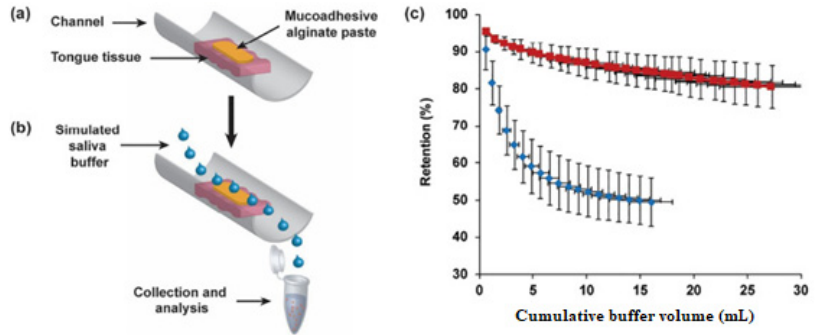
Figure 5. Assessment of mucoadhesion. ( a , b ) – preparation and buffer flow on sample, ( c ) Mucoadhesion evaluation of 3% ( w / v ) alginate-fluorescein ( ) paste; ( ) cross-linked paste on porcine tongue. Reprinted from ref. [88] with permission from Elsevier (2018).